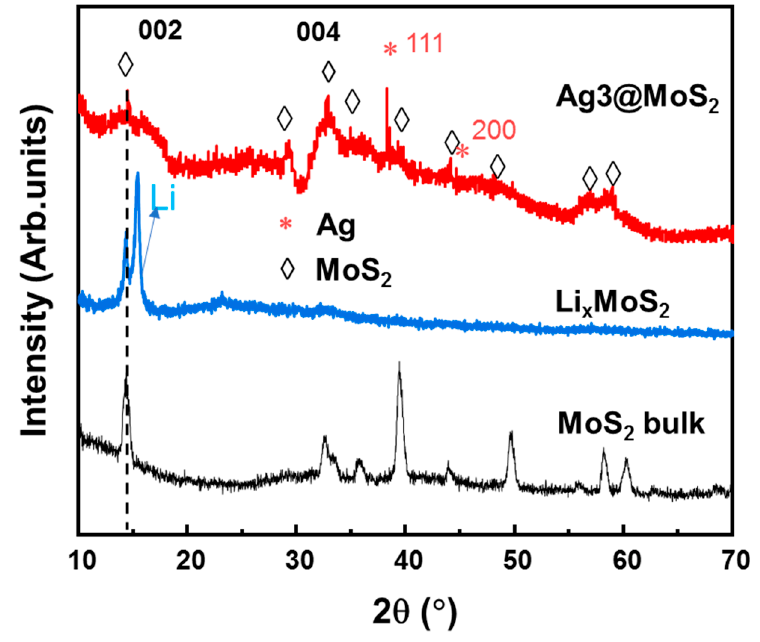
Figure 2. X-ray diffraction patterns of bulk MoS 2 , Li x MoS 2 , and Ag3@MoS 2 materials. The structure of Ag-decorated MoS 2 was further confirmed by TEM measurements.